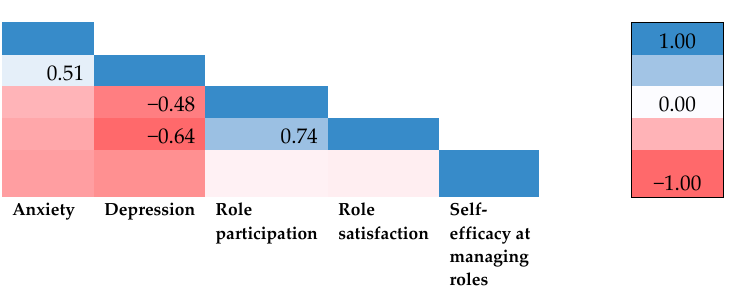
Figure 1. Heat map. Correlations between psychological and role functioning. Note. Pearson’s product–moment correlations were used to determine relationships between variables ( n = 18).